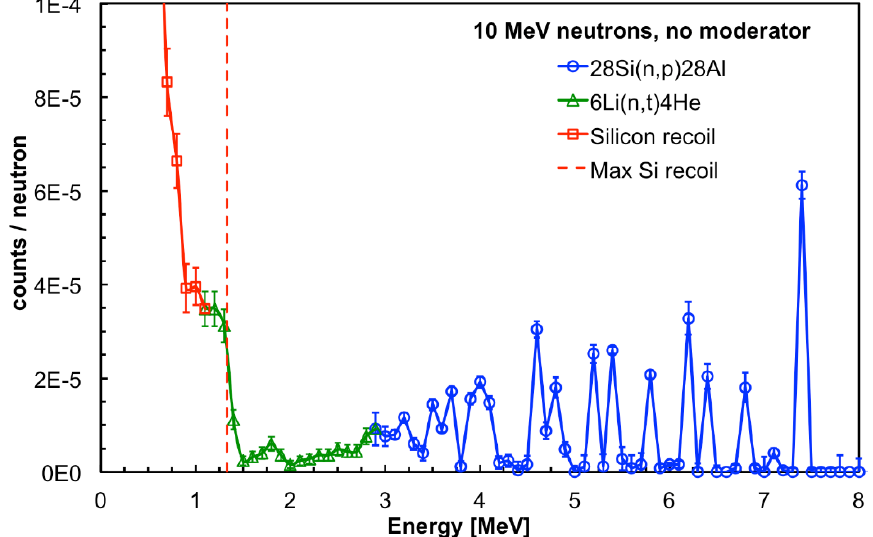
Figure 13. GEANT4 simulation of the SiLiF response to 10 MeV neutrons without the moderator surrounding the detector (see text).